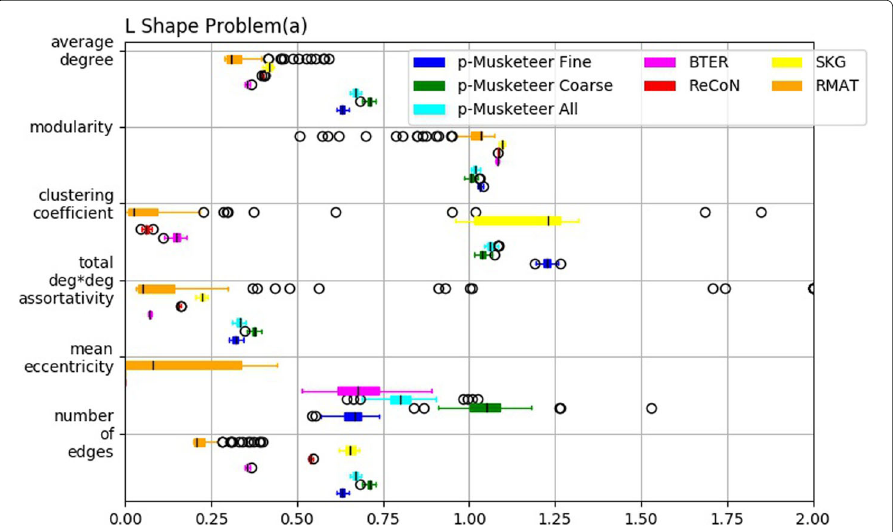
communities (e.g., mesh structures in case of our input road network) in the generated